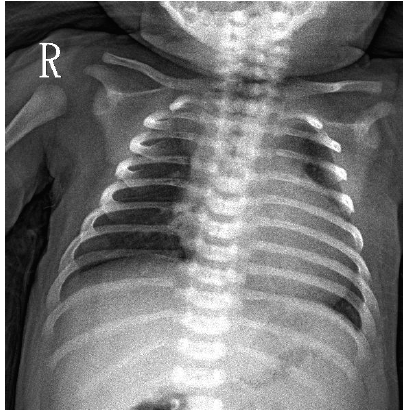
Figure 1. CXR at D7 in a newborn with a positive Pompe newborn screening result. Mild cardiomegaly was noted.